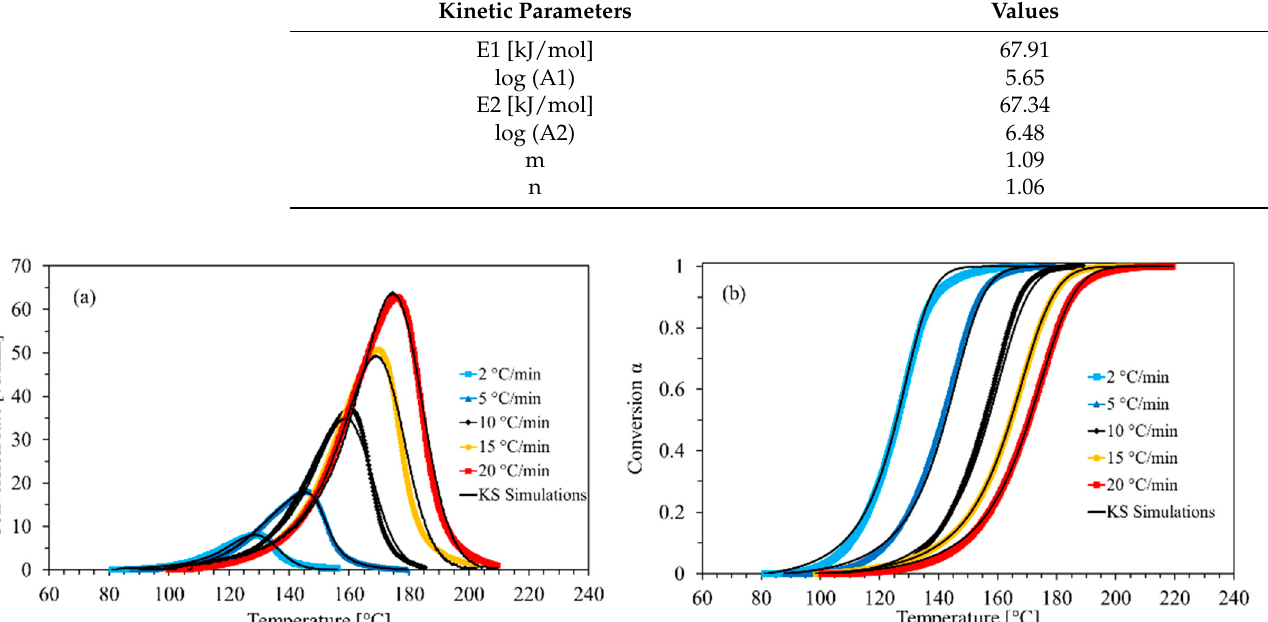
Figure 5. DEA evaluation: ( a ) ion viscosity and temperature plotted against time ( b ) Cure index at different isothermal temperatures plotted against time; ( c ) natural logarithm of time plotted against the reciprocal of the absolute temperature (integral isoconversional method) at specific cure indeces with the corresponding regression lines; ( d ) apparent activation energy E a plotted against the cure index with standard error.